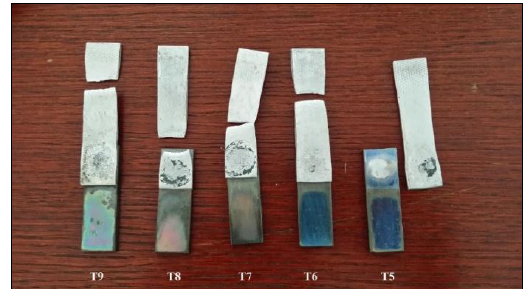
Figure 5. Successful tensile test parameters. Table 5. Tensile test results.